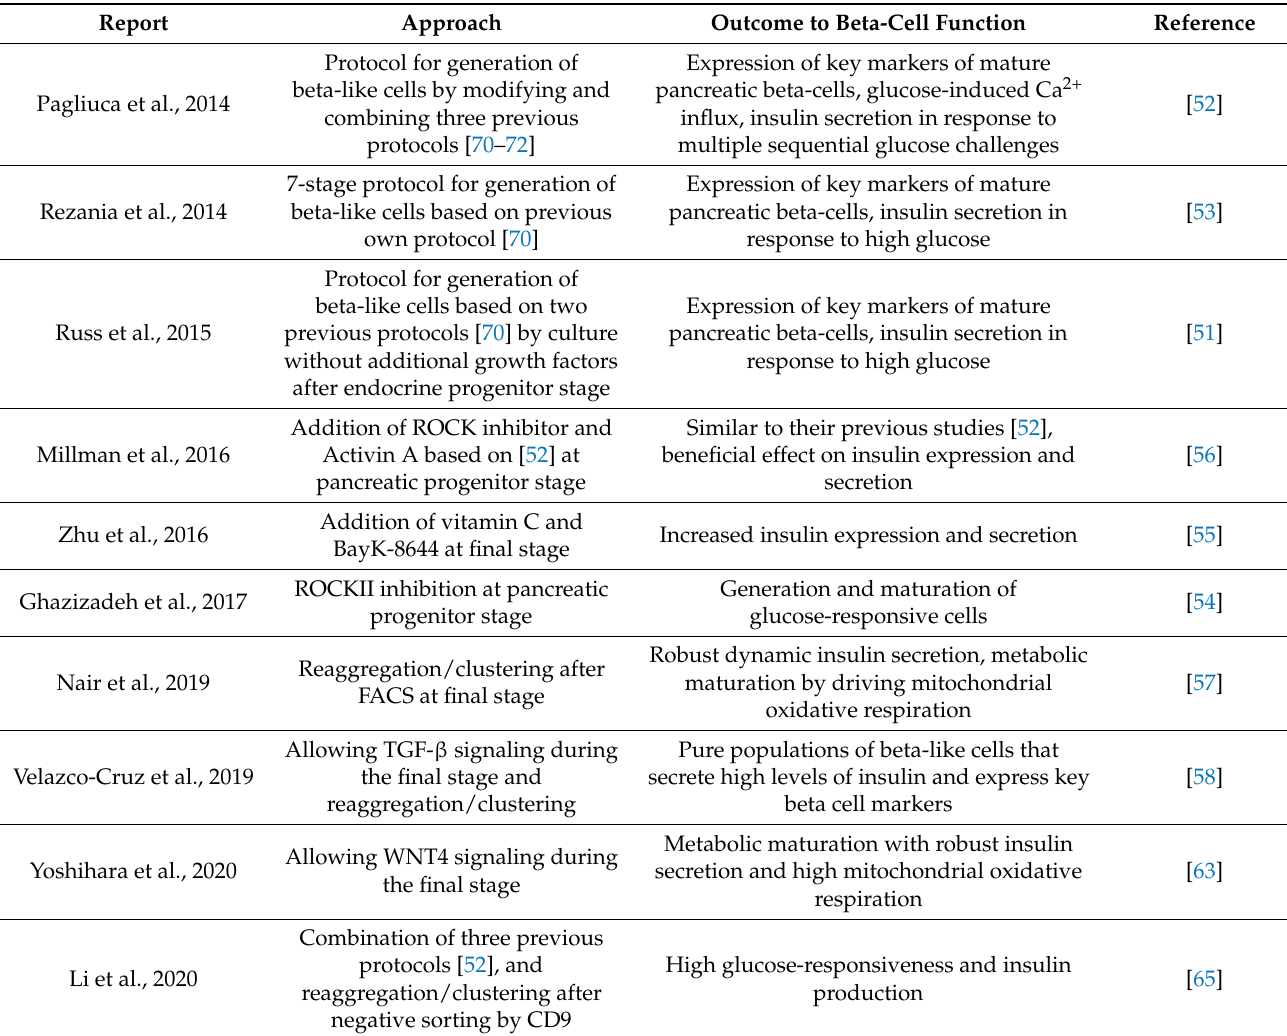
Table 1. Overview of protocols for the generation of stem cell-derived beta